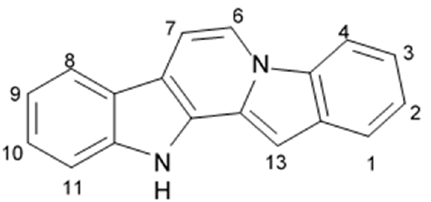
Figure 3. Structure of 12H-pyrido[1,2-a:3,4-b ′